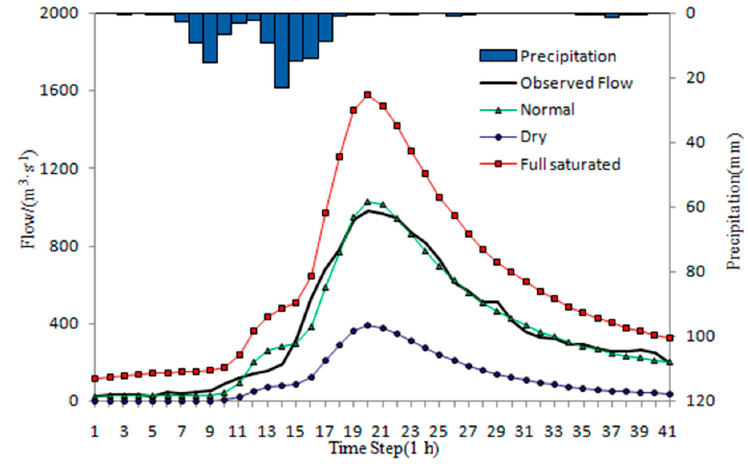
Figure 2. Observed and simulated results using different initial state variables. Table 4. The initial state variables of three